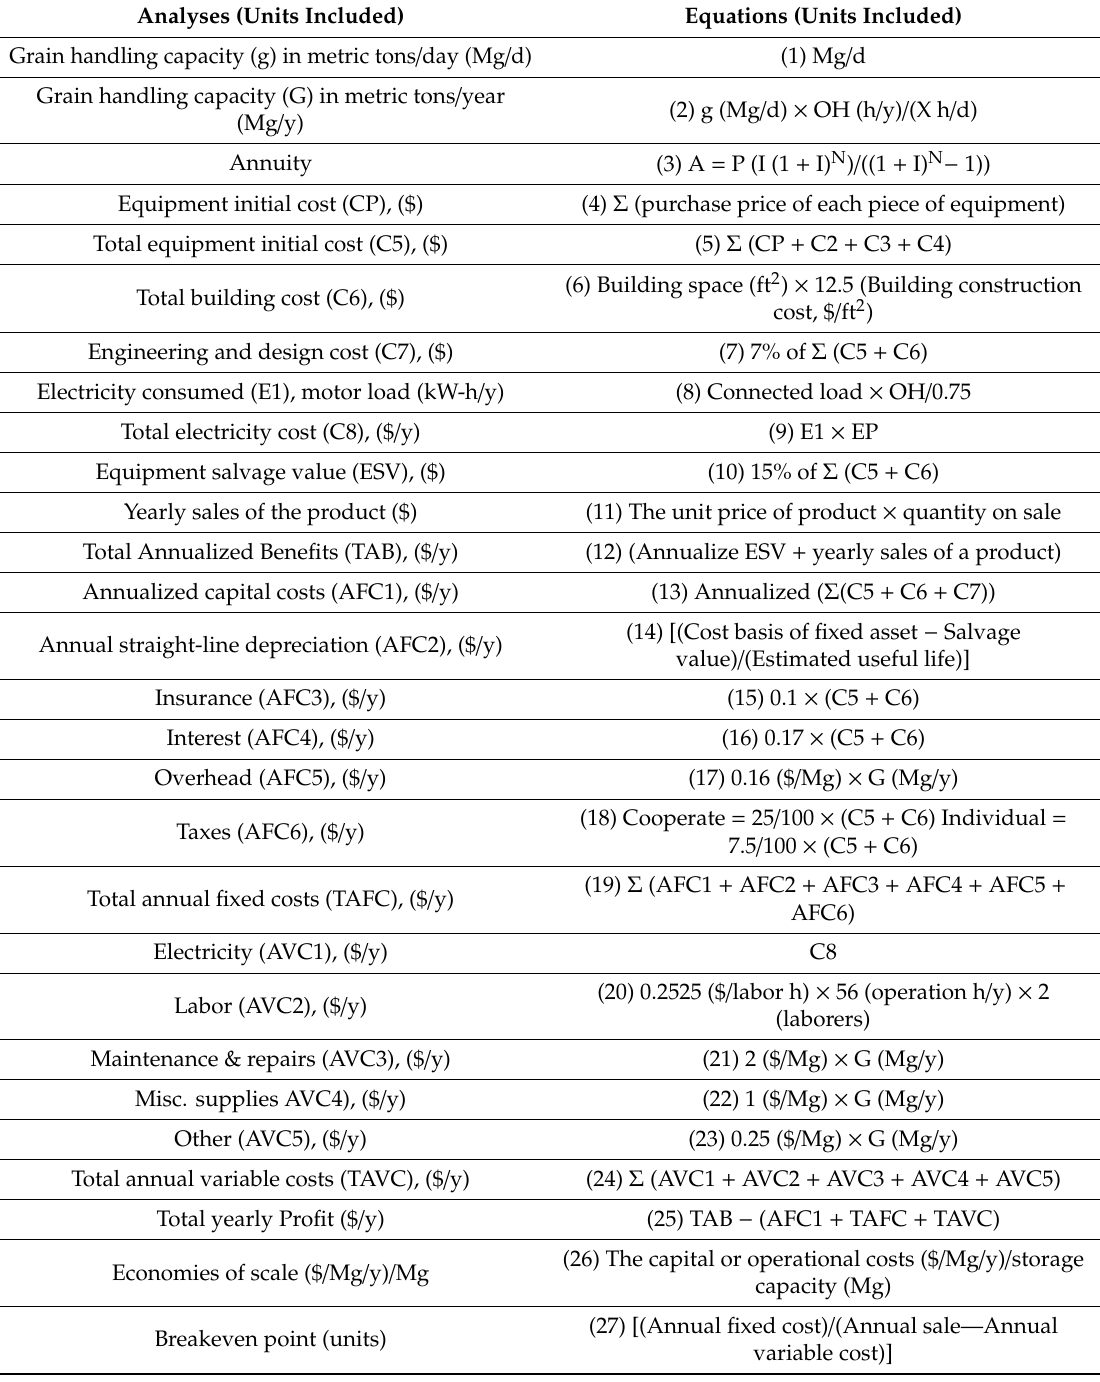
Table 4. Equations used for the cost analysis